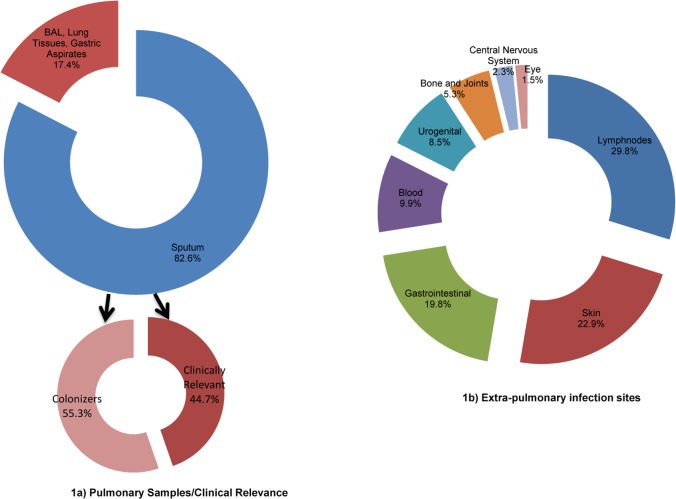
Proportion of pulmonary and extrapulmonary site of infections in the study.This figure shows the source of NTM isolation in the study from different pulmonary and extrapulmonary clinical samples.